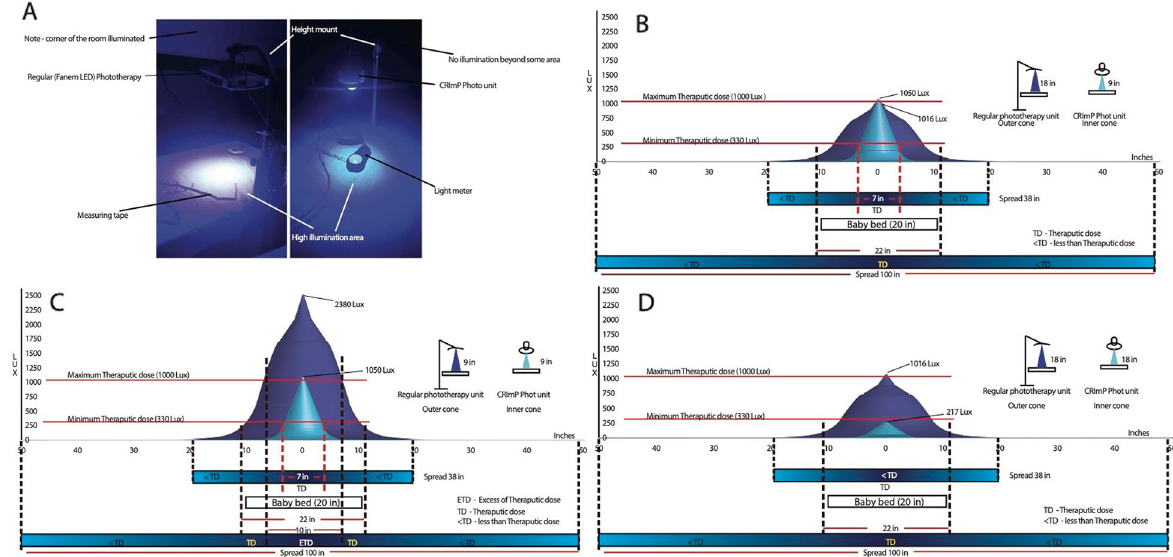
Fig. 3 A Graphical representation of the spread of light intensity of both conventional phototherapy and photo unit. B Both at their designed heights, i.e. 18 inch and 9 inch, respectively. C Both at the height of 9 inch. D Both at the height of 18